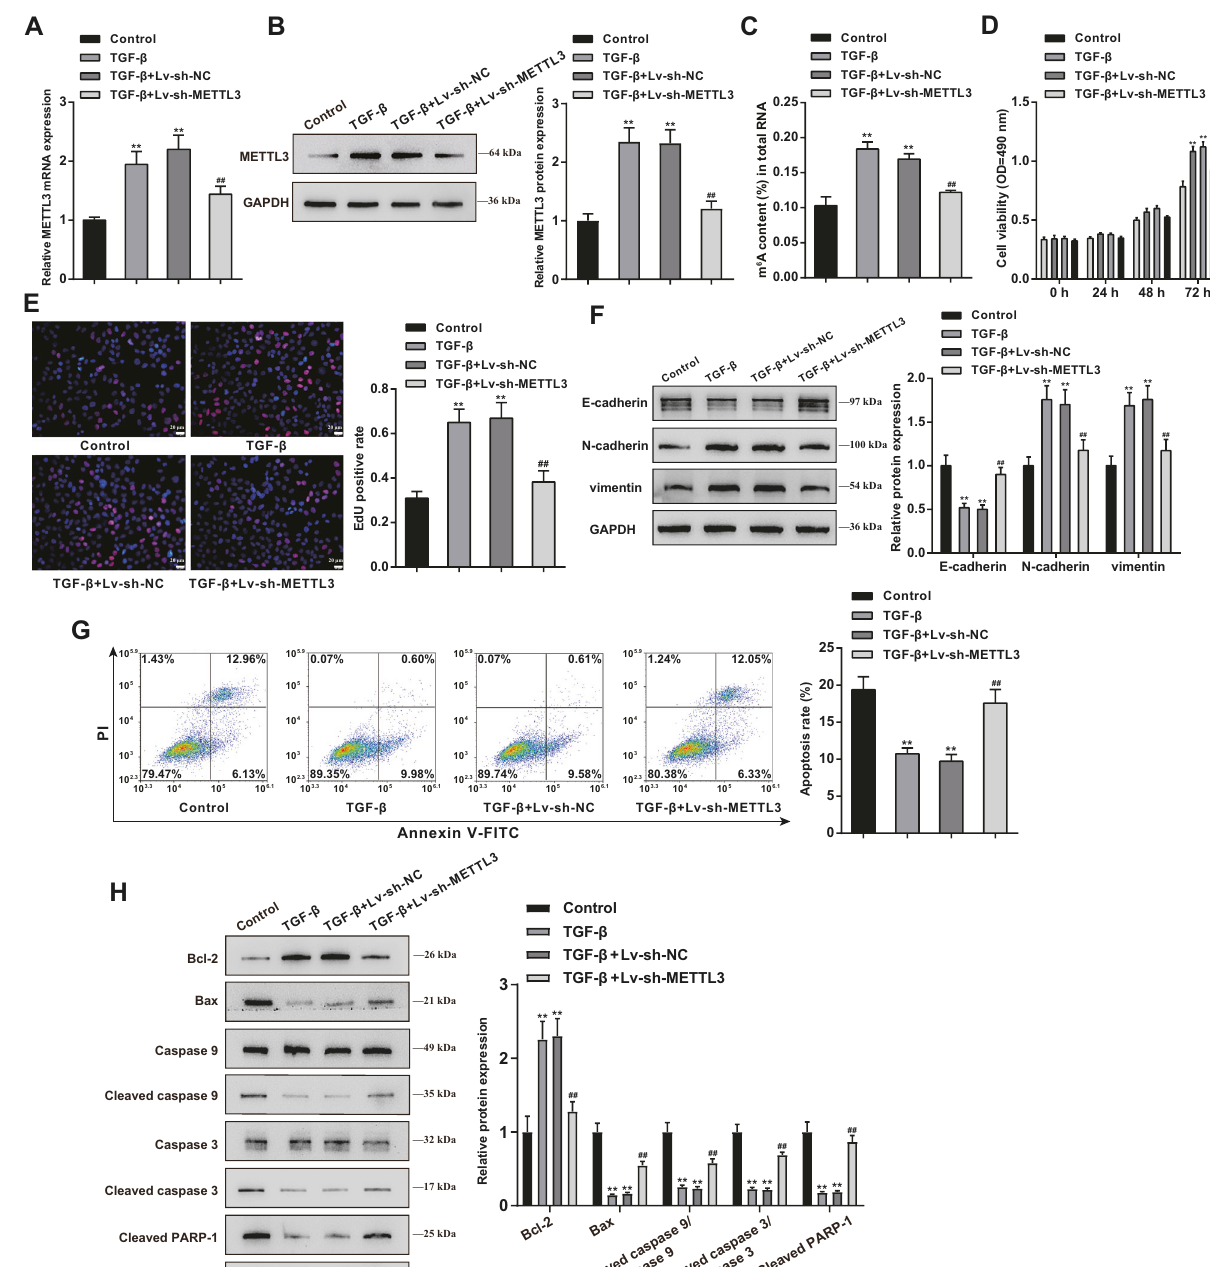
Fig. 3 Effects of METTL3 knockdown on proliferation, apoptosis, and EMT of TGF- β -treated BPH-1 cells. METTL3 knockdown was achieved in TGF- β -treated BPH-1 cells by transducing Lv-sh-METTL3 and then examined for A , B METTL3 expression using qRT-PCR ( A ) and Immunoblotting ( B ); C m 6 A status in RNA using an m 6 A RNA Methylation Assay Kit; D cell viability using MTT assay; E DNA synthesis using EdU assay; Scale bar = 20 μ m; F the protein levels of E-cadherin, N-cadherin, vimentin using Immunoblotting; G cell apoptosis using fl ow cytometry; H the protein levels of Bcl-2, Bax, Caspase 9, cleaved caspase 9, Caspase 3, cleaved caspase 3, and cleaved PARP-1 using Immunoblotting. ** P < 0.01, compared with the control group; ## P < 0.01, compared with the TGF- β + Lv-sh-NC group. tissues and signi fi cantly reversed the effects of METTL3 knock- METTL3 knockdown were partially eliminated by PTEN knockdown down upon these proteins ( ## P < 0.01; Fig. 6G – K). Cell apoptosis ( ## P < 0.01; Fig. 6D, E). A representative prostate from each group was shown (Fig. 6F). H&E staining also indicated the improvement investigation saw similar trends: METTL3 knockdown signi fi cantly of hyperplasia symptoms by METTL3 knockdown but the promoted, whereas PTEN knockdown inhibited apoptosis in exacerbation by PTEN knockdown ( P < 0.01). Similarly, the hyperplasic prostate ( P < 0.01), and PTEN knockdown partially improving effects of METTL3 knockdown were partially abolished attenuated the effects of METTL3 on apoptosis ( ## P < 0.01; Fig. 6L). by PTEN knockdown ( ## P < 0.01; Fig. 6F). PTEN knockdown Moreover, the dynamic effects of METTL3 and PTEN on the levels of transcription factors orchestrating proliferation, EMT, and signi fi cantly increased the contents of Ki67, PCNA, N-cadherin, apoptosis in BPH model were also investigated (Fig. S6A). METTL3 and vimentin ( P < 0.01), but decreased E-cadherin in rats ’ prostate Cell Death and Disease (2022)